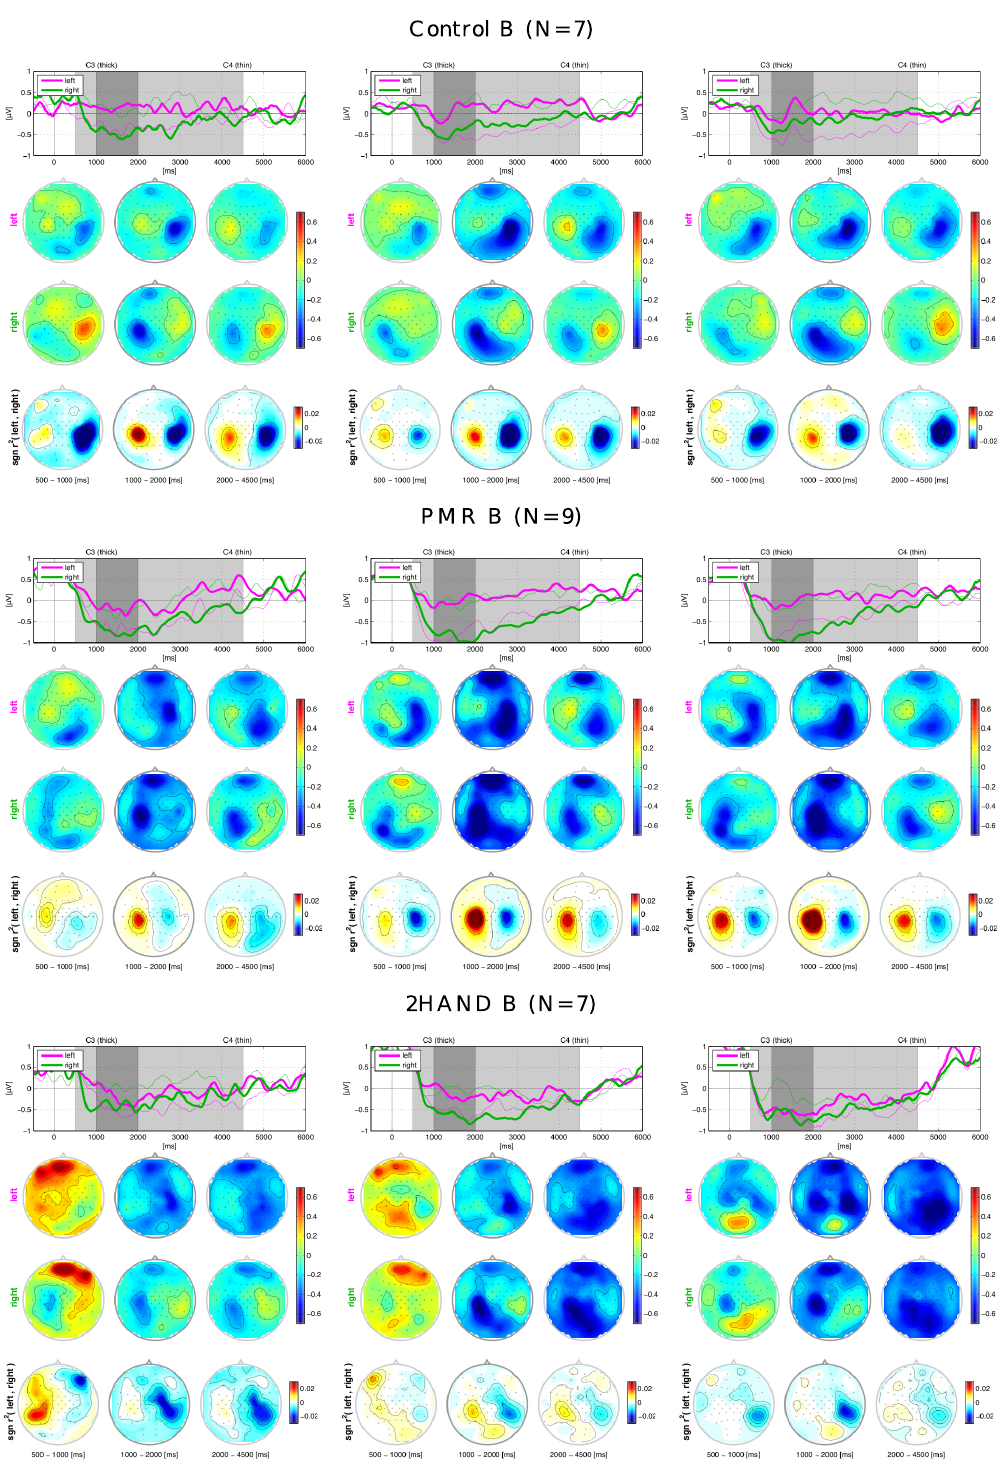
Fig 4. Grand average ERD/ERS for class combination. left-right and intervention groups in Berlin. ‘ N ’ is the number of participants of each group. From left to right: runs 1 – 3, runs 4 – 5, runs 6 – 7. The time plots in the first rows picture the evolution of the ERD/ERS for about 6000 ms at C3 (thick lines) and C4 (thin lines). At time 0 is the onset of the cue, at times 1000 – 4000 the display of the feedback. Magenta lines refer to left MI trials, green lines to right MI trials. The scalp plots underneath refer to the shaded areas of the time plots and show the distribution of the ERD/ERS. In the second rows, the scalp plots of the left MI trials, in the third rows the scalp plots of the right MI trials and in the fourth the scalp plots of the sign-r 2 .